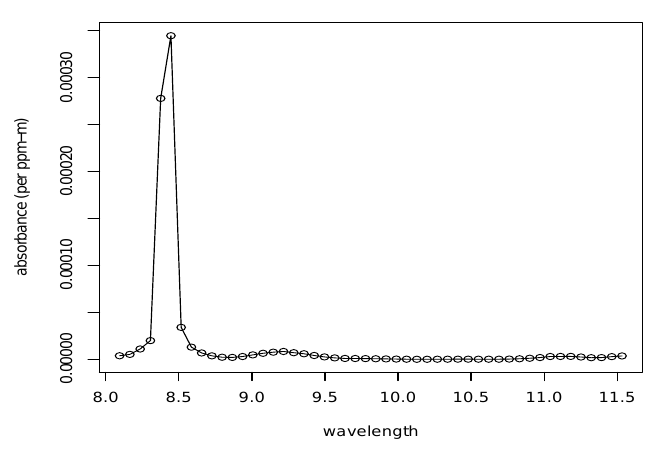
Figure 6. Gas 7 Absorbance